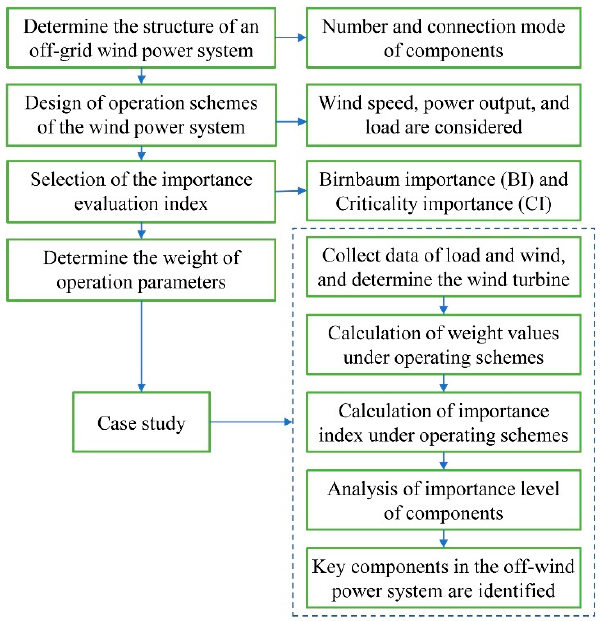
Figure 1. Framework of the importance analysis–based weight evaluation developed for study.